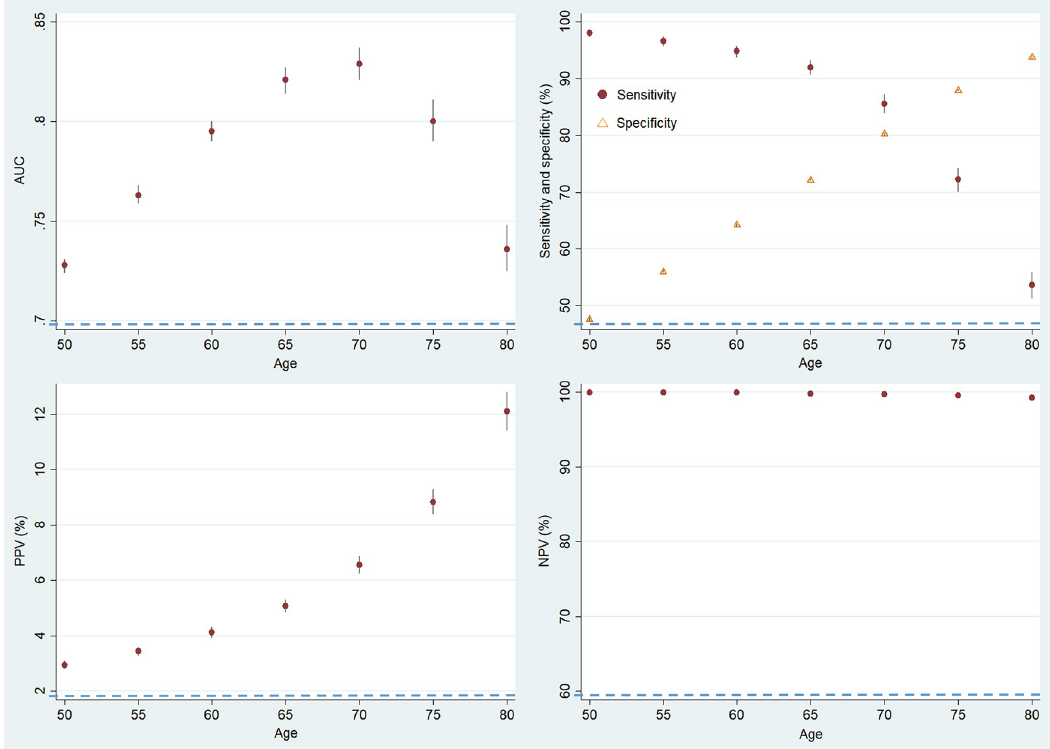
Fig 2. Sensitivity analysis of NHIS-NSC cohort with changing the age threshold. AUC, area under the receiver operating characteristic curve; PPV, positive predictive value; NPV, negative predictive value. The 95% confidence intervals for each point are shown as vertical